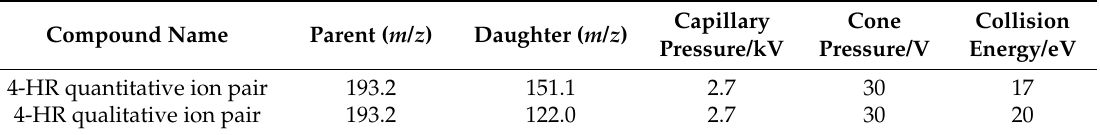
Table 3. Conditions of multiple reaction monitoring for